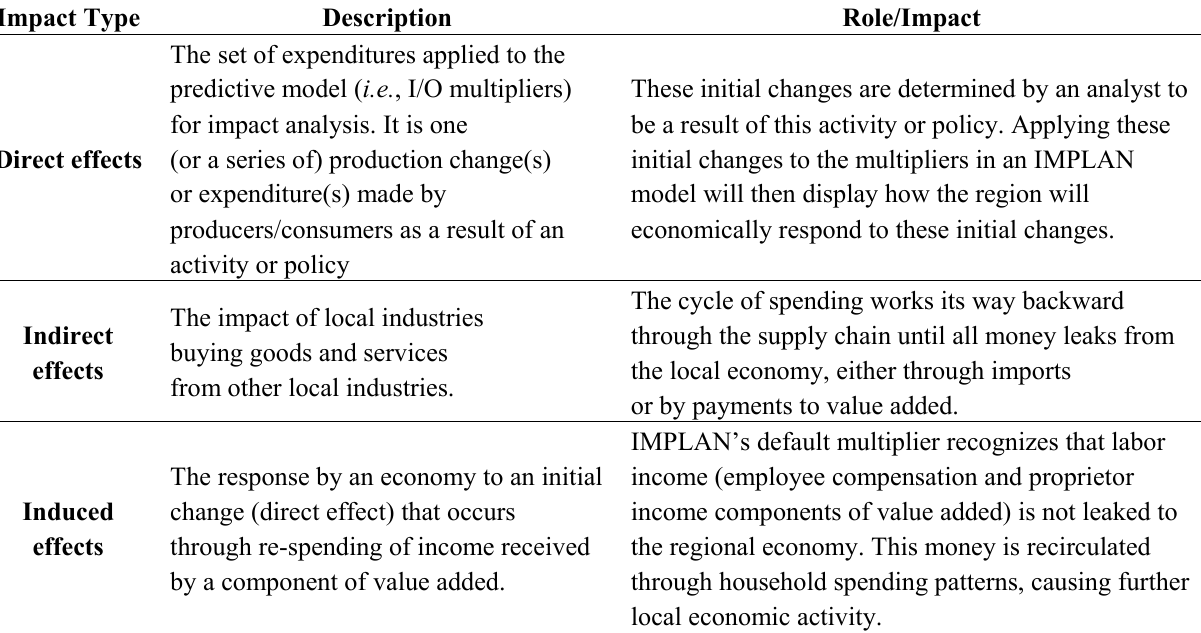
Table 1. Categorization of impacts in